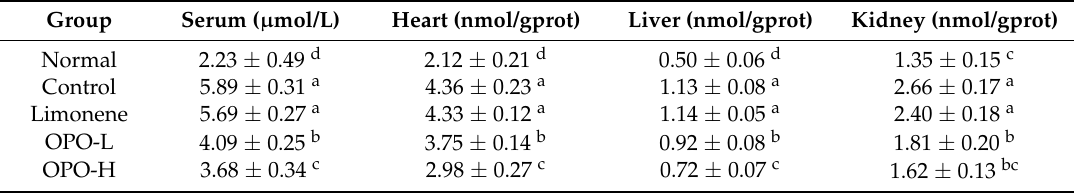
Table 4. Malondialdehyde (MDA) content in serum, heart, liver and kidney of L -NNA-induced hypertensive rats.